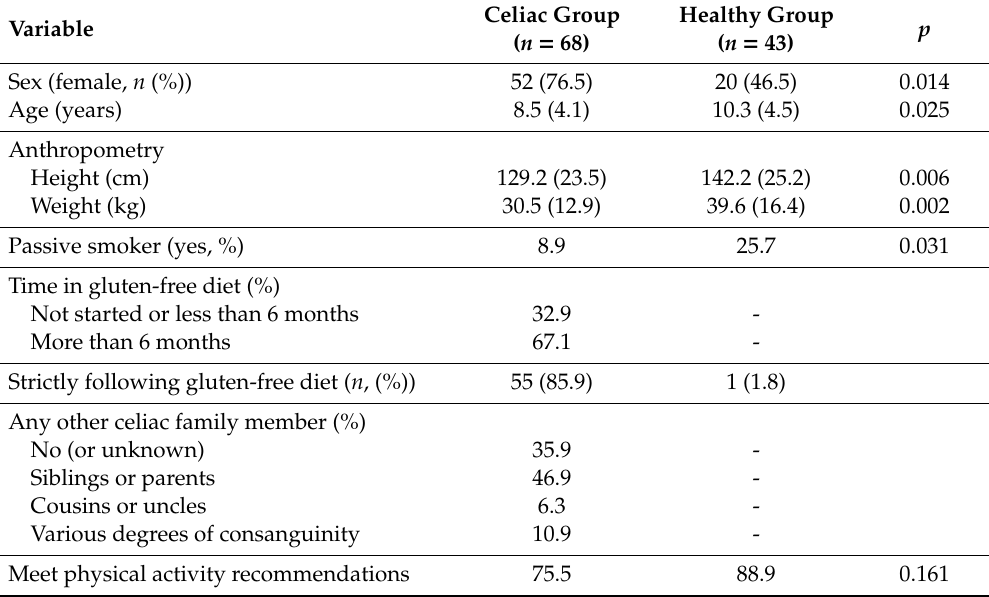
Table 1. Anthropometric, clinical and sociodemographic characteristics of the study